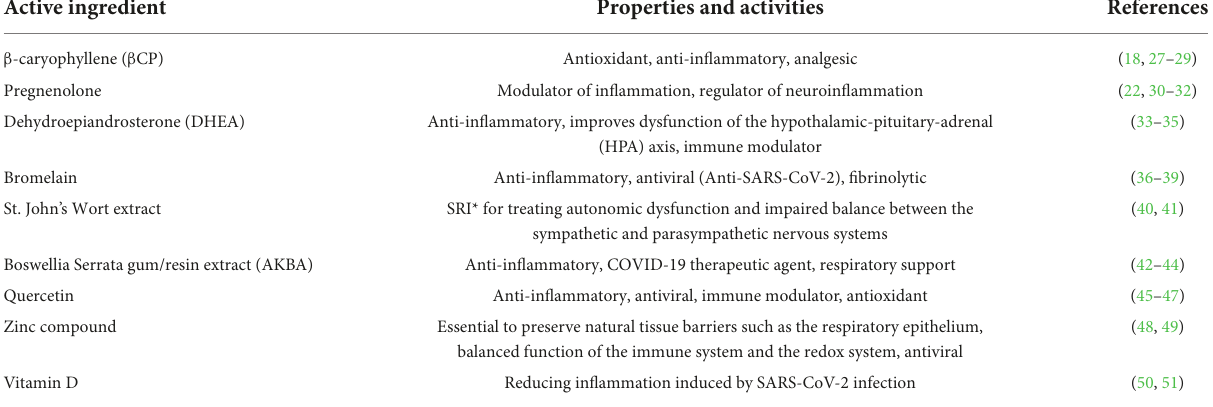
TABLE 1 List of compounds included in our nutraceutical combination and their relevance for COVID long